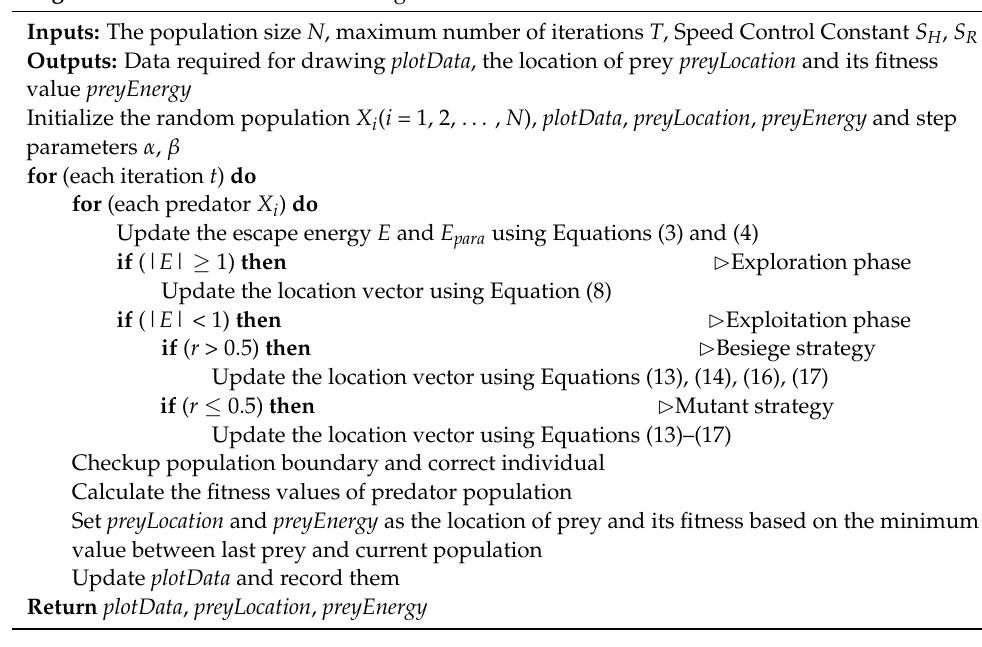
Algorithm 1. Pseudocode of OMO